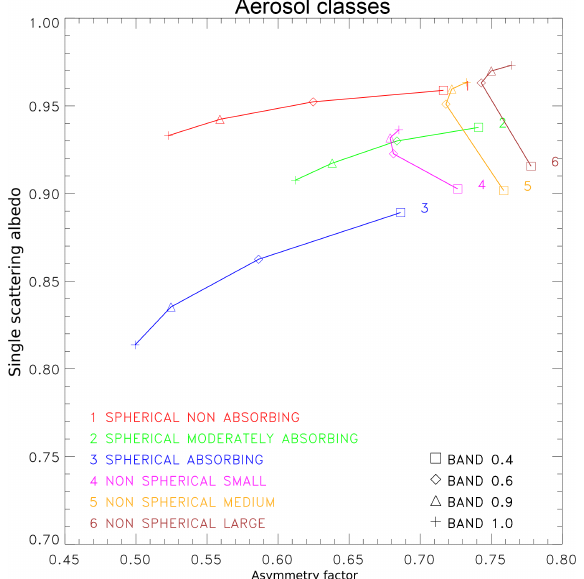
Figure 1. Aerosol dual-mode models based on Govaerts et al. (2010b) in the { g,ω 0 } space derived from the aggregation of aerosol single-scattering properties retrieved from AERONET observations (Dubovik et al., 2006). Classes 1 to 3 are dominated by the fine mode and 4 to 6 by the coarse one.